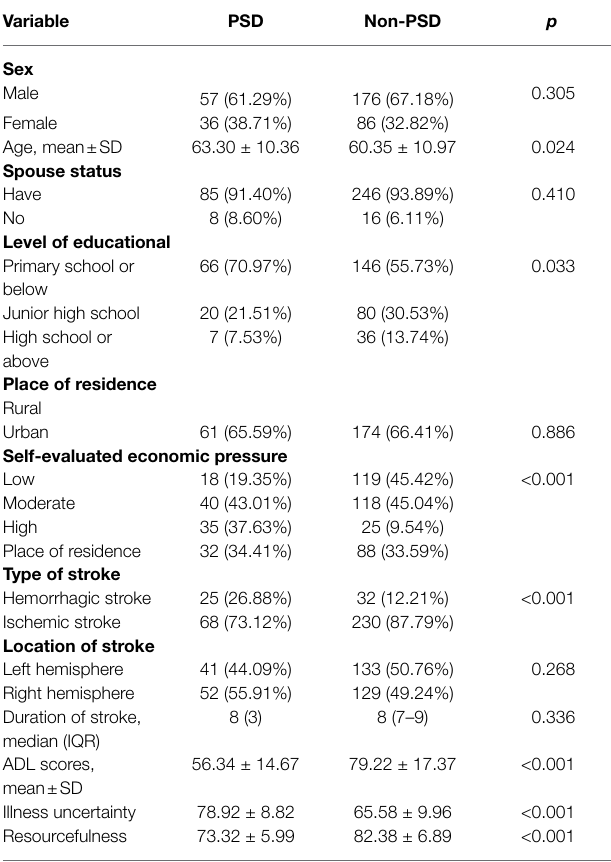
TABLE 2 | The differences between non-PSD and PSD group ( N = 355).